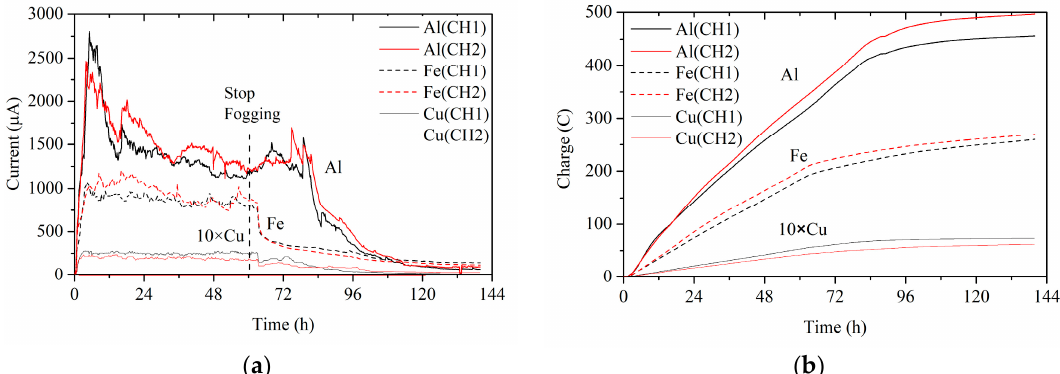
Figure 10. Corrosion currents ( a ) and electric charges ( b ) of sensors made of aluminum, iron, and copper in salt spray tests.